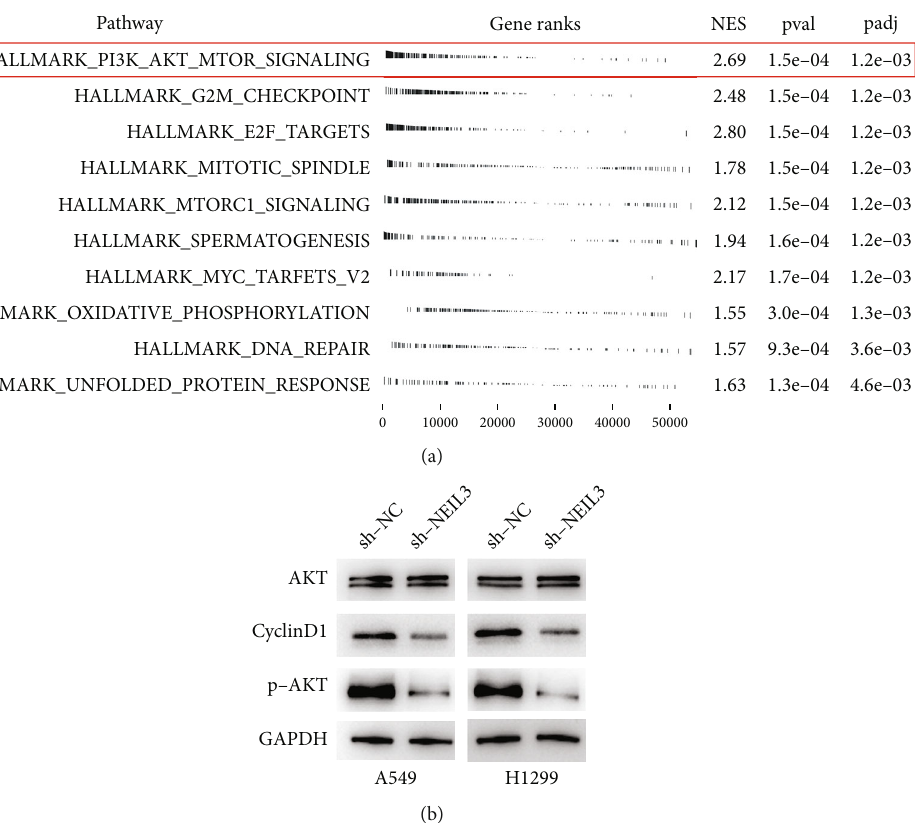
Figure 6: NEIL3 regulated the activation of the PI3K/AKT/mTOR signaling pathway. Notes: (a) GSEA in patients with low and high NEIL3 expressions; (b) western blot assay was performed to detect the key molecule of PI3K/AKT/mTOR signaling pathway in control and NEIL3 knockdown